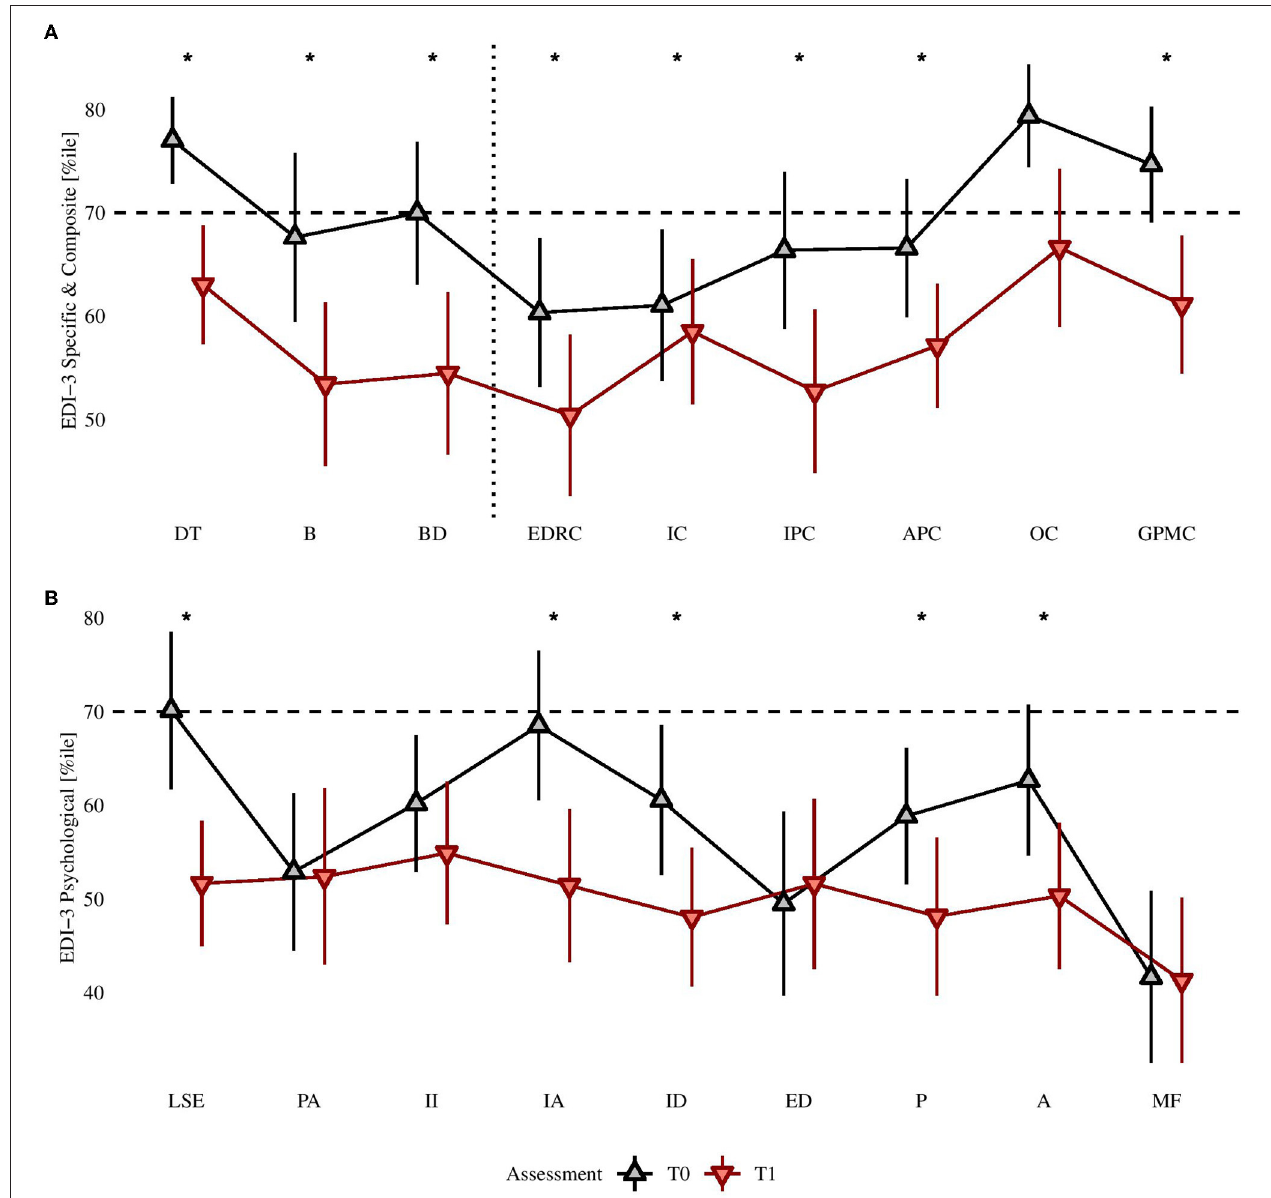
FIGURE 2 | (A) EDI-3, Eating disorder specific and composite scores confronted pre- and post-treatment; (B) EDI-3 psychological scales confronted pre- and post-treatment. * Post treatment is lower than pre-treatment at statistically significant level, after Benjamini-Hochberg’s correction, with p < 0.050.